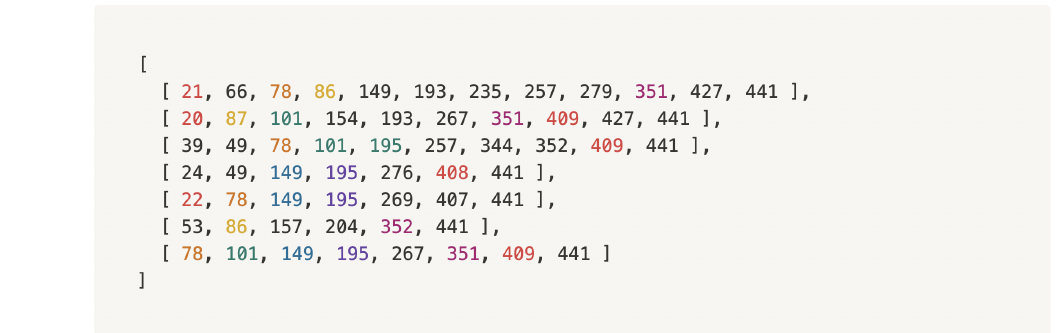
Figure 23. Topic segmentation points in ‘SAT’.